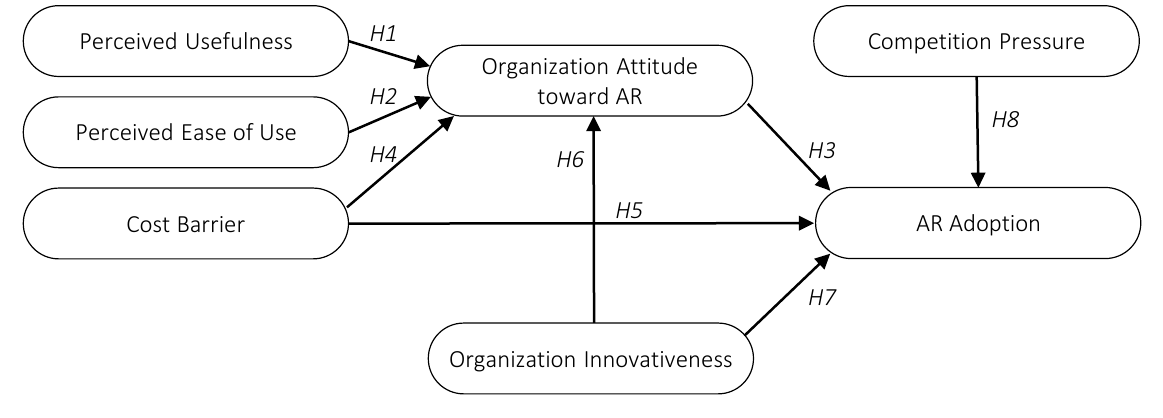
Figure 1. Proposed research